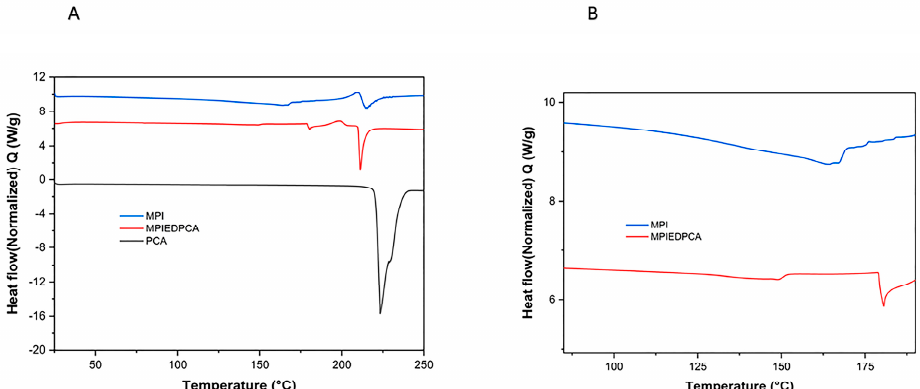
Figure 6. DSC thermograms of MPI, conjugate and PCA ( A ) and MPI and MPIEDPCA ( B ) showing endothermic peak.